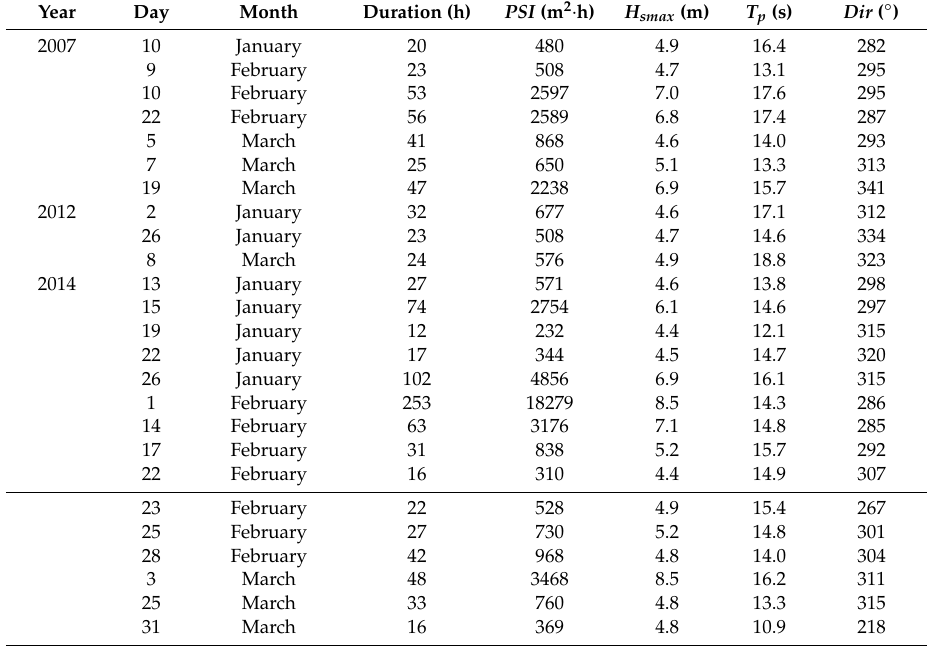
Table 1. Characteristics of storm events identified in the wave climate selected: date (year, day, and month), duration, power storm index ( PSI ), maxima significant wave height ( H smax ) with peak wave period ( T p ) and wave direction ( Dir ) associated (0 ◦ corresponds to